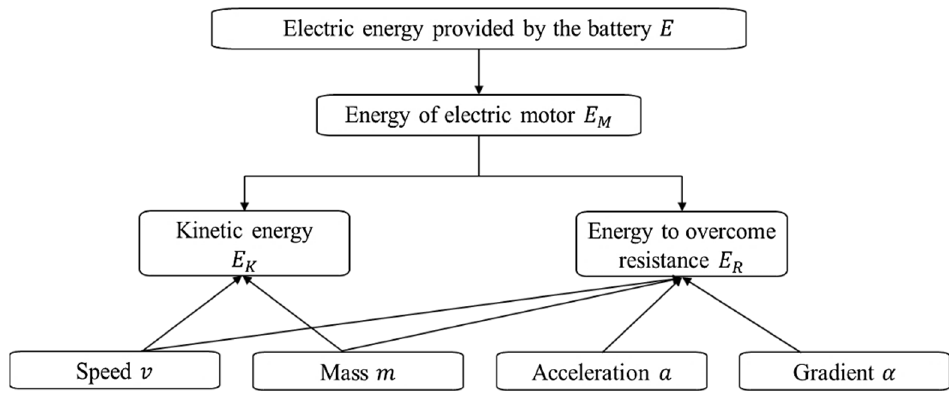
Figure 4. Flow of consumed battery energy.